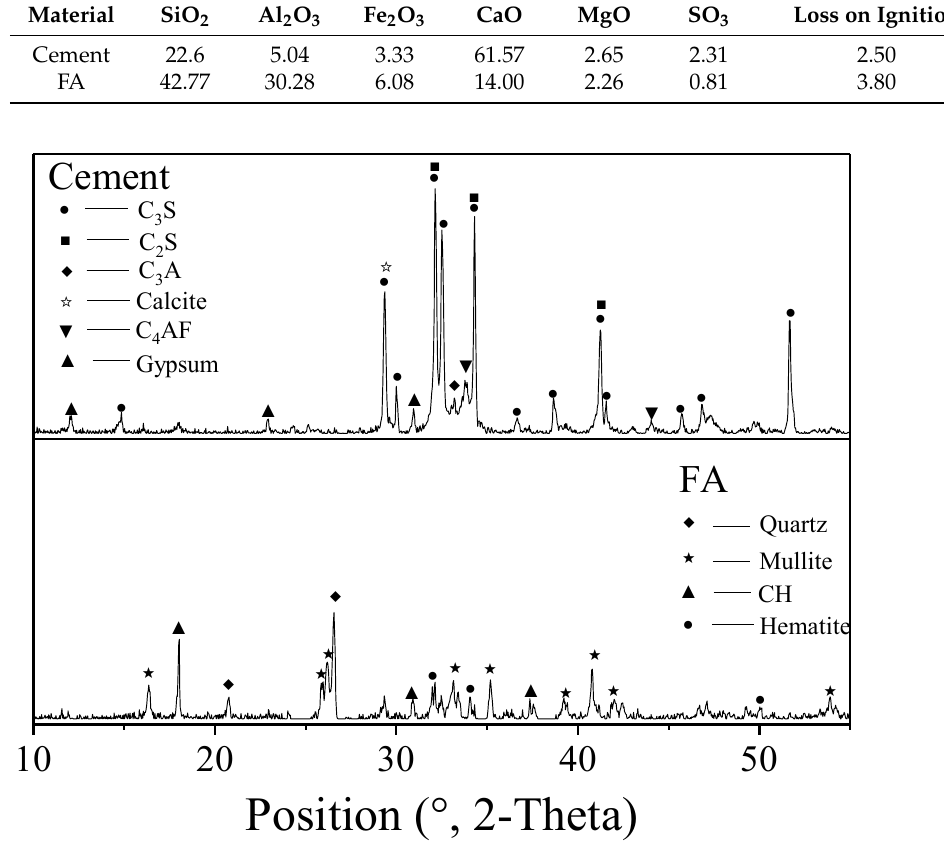
Table 1. Chemical compositions of cement and FA/%.